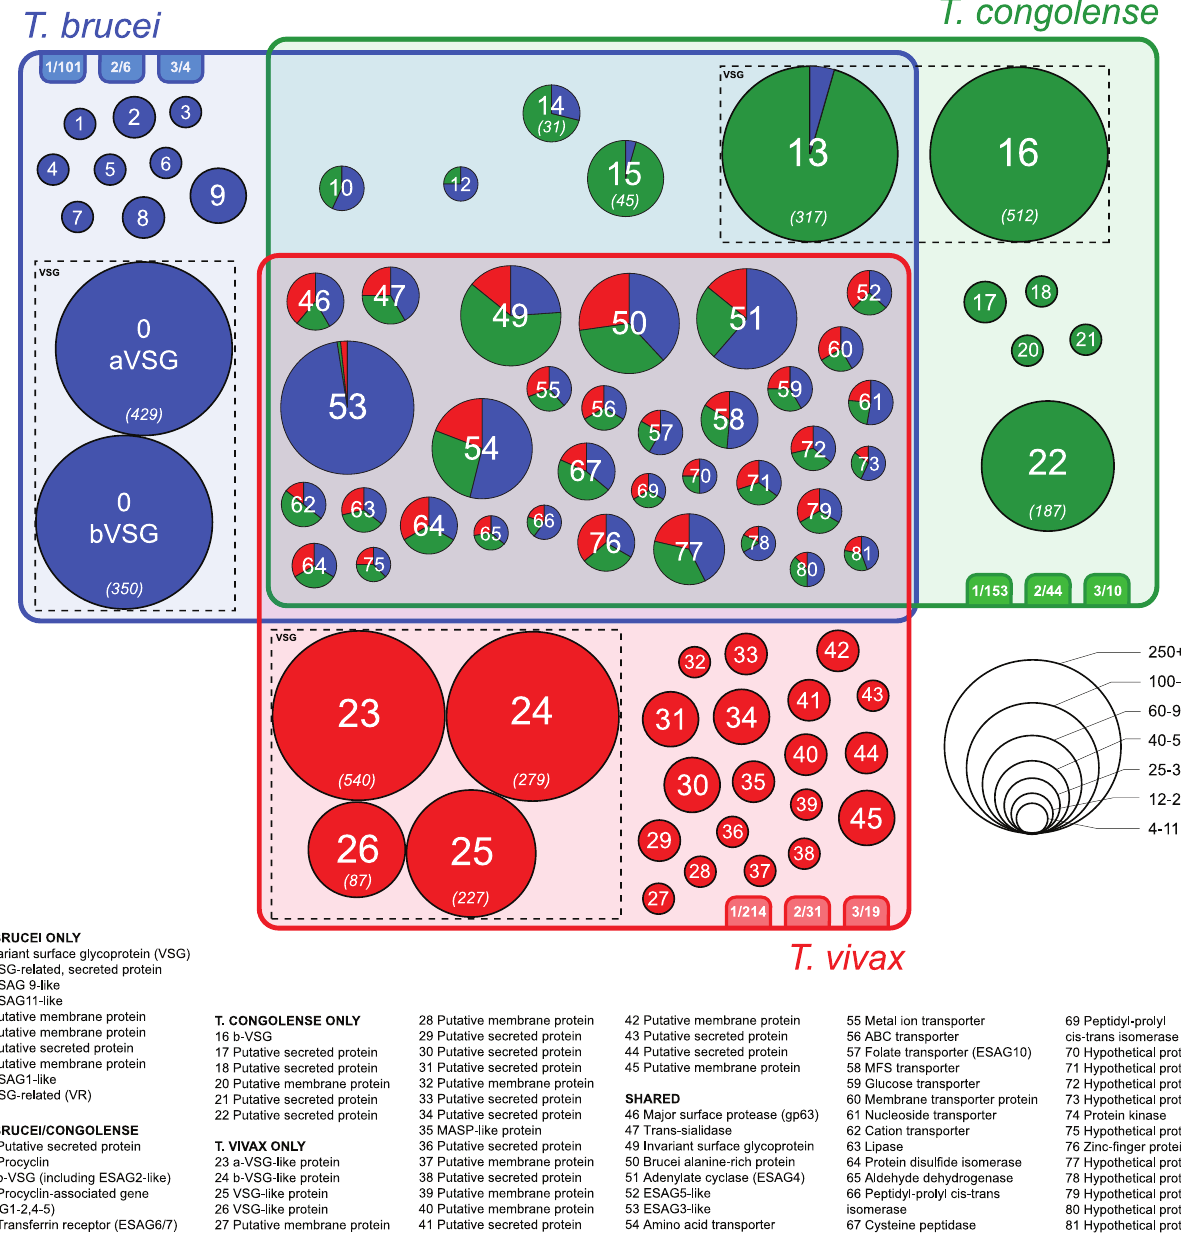
Figure 1. The taxonomic distribution of gene families in the cell-surface phylome, displayed in a Venn diagram. Phylogenies for all families are available through GeneDB. Each circle represents a family (i.e. . 3 gene copies). The label in each circle refers to the description key, while size reflects the number of genes it contains; for large families the absolute number is shown in parentheses. For families present in multiple species, a pie chart is shown indicating relative gene numbers. The three tabs attending each species domain show the number of single-copy genes, pairs and triplets also predicted to have cell surface roles and to be species-specific (e.g. 101 singletons in T. brucei ).